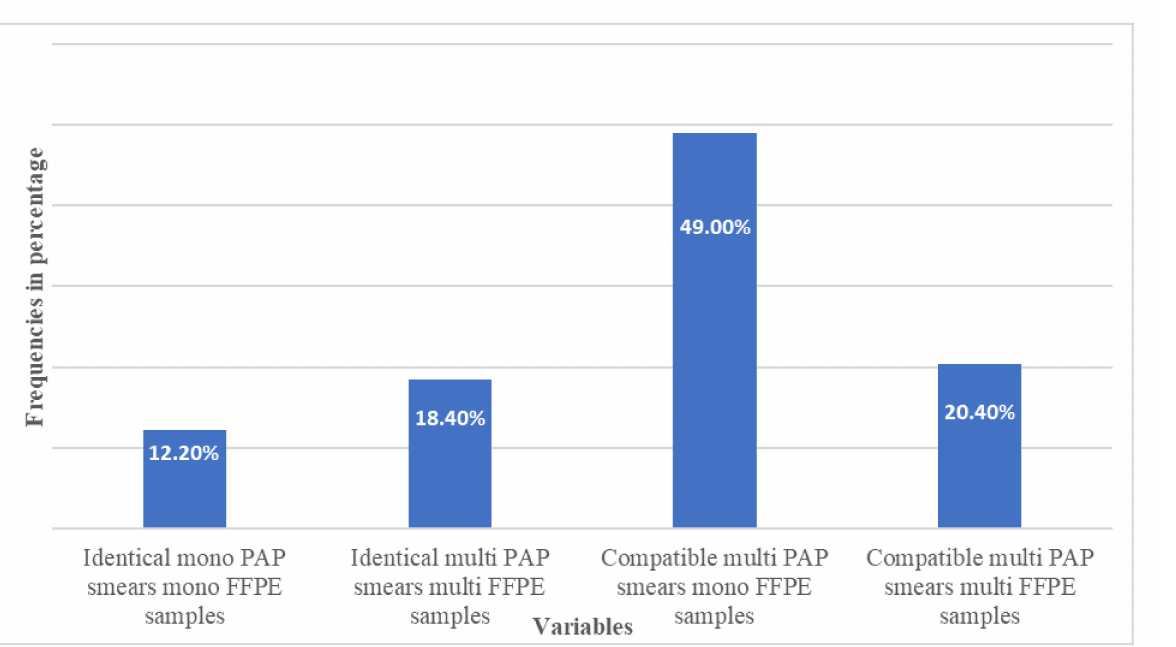
Figure 1. PAP smear and FFPE cone samples originated from the same patient in all 49 cases. Variables are based on the agreement of the human papillomavirus genotype prevalence in the two sample types. Most of the samples (49.00%) belong to the compatible category with multi-HPV infections in PAP smears coupled with mono-HPV infection in FFPE cone samples. Identical: the detected HPV genotypes are exactly the same in the PAP smears and their FFPE cone sample pairs. Compatible: at least one of the genotypes detected in multi-PAP smears was also found in their FFPE cone sample